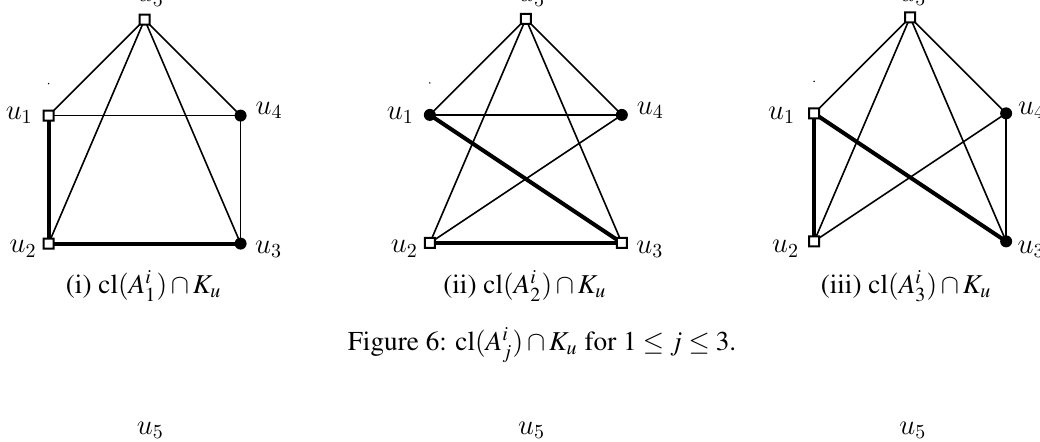
) ∩ K u for 1 ≤ j ≤ 3. j